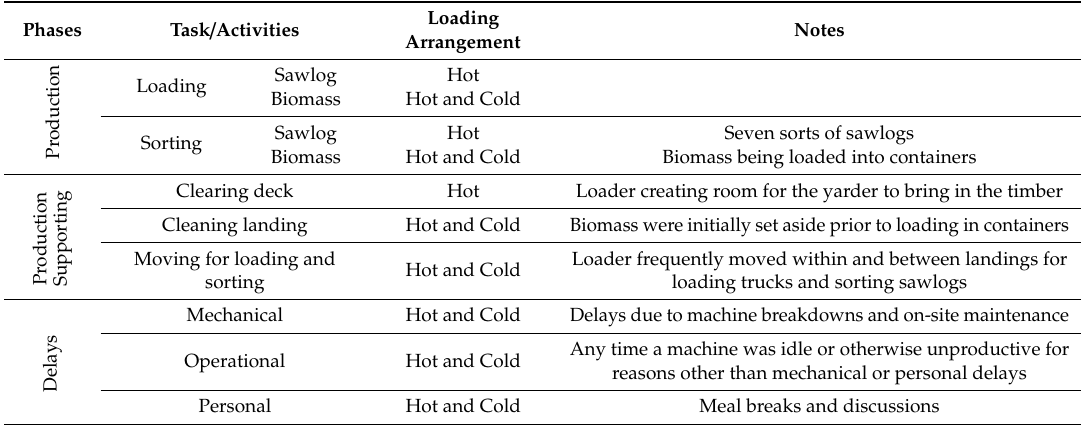
Table 1. Operational tasks performed by the loader during the yarding